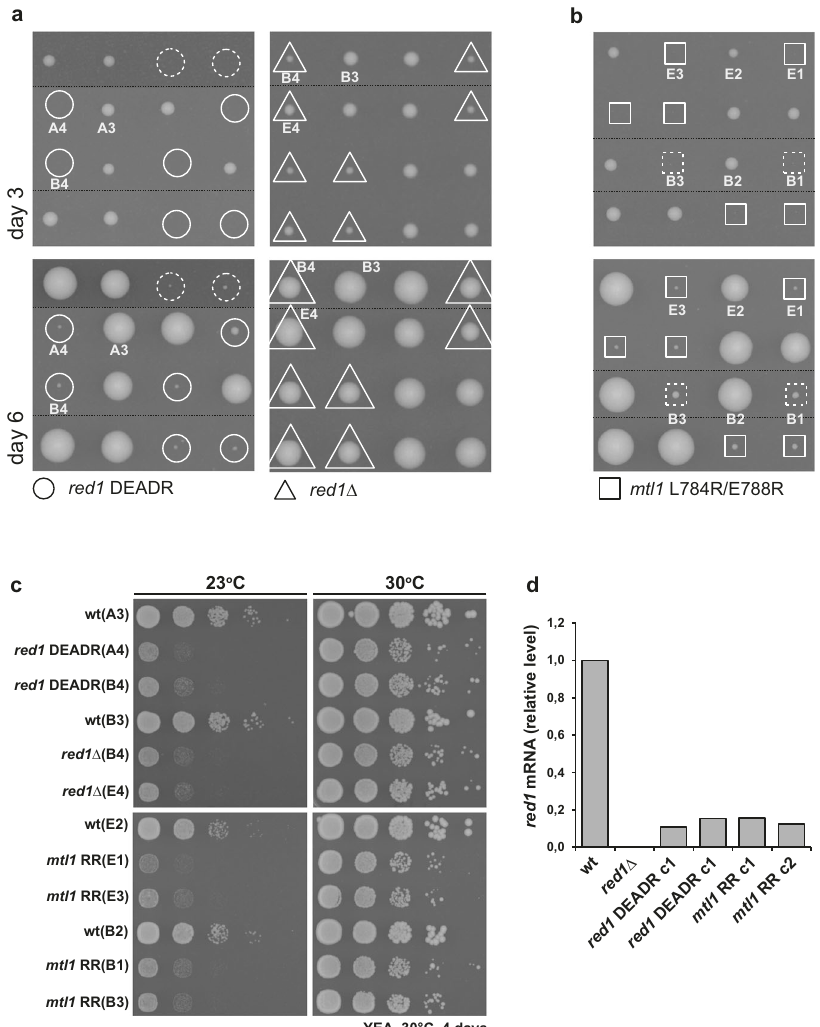
Fig. 6 In vivo analysis of red1 DEADR and mtl1 RR variants. a Tetrad dissection of red1 DEADR variant and red1 Δ . The wild type (wt) colonies grew after 3 days, whereas the DEADR variant (circles) appeared after 6 days. red1 Δ colonies (triangles) grew similarly to wt colonies. b Tetrad dissection of mtl1 L784R/E788R ( RR ) variant. The wt colonies grew after 3 days, whereas mtl1 RR (squares) appeared after 6 days. c Phenotypic growth assay after 4 days at different temperatures. The red1 DEADR variant, red1 Δ , mtl1 RR, and respective wt, were spotted after serial dilutions. The growth of the mutant strains at 30 °C is comparable to wt; however, at 23 °C all mutants exhibit a slow growth phenotype. d qPCR analysis of the red1 mRNA expression level. For the analysis, red1 DEADR (dotted circles) and mtl1 RR (dotted squares) were used together with wild type and red1 Δ strains. Two biological replicates were performed (labeled with c1 and c2), n = 2. Source data are provided as a Source Data fi previously suggested by tandem-af fi nity puri fi cation of the com- plex from a red1 Δ strain 21 . We also show that the interaction between Red1 and the Pab2 – Red5 – Rmn1 submodule is facilitated by Rmn1 and Red5 but not Pab2. In addition, Pab2 and Rmn1 also interact with Mmi1 and Iss10, suggesting that Pab2, Red5, Rmn1, Iss10, and Mmi1 form one large functional module. We identi fi ed a direct interaction between the canonical poly(A) polymerase Pla1 and Red1. Within the MTREC complex Pla1 is required for the hyper-polyadenylation of CUTs and meiotic mRNAs, and has a critical role in the proper degradation of these transcripts 32 . This suggests that the mammalian PAXT complex might also interact directly with a poly(A)-polymerase to exten- sively polyadenylate substrate RNAs that are recognized by this complex. Although in our Y2H-interaction map, every known subunit of the MTREC complex is accounted for, we cannot exclude that additional interactions exist within the complex that we could not retrieve with the Y2H technique.